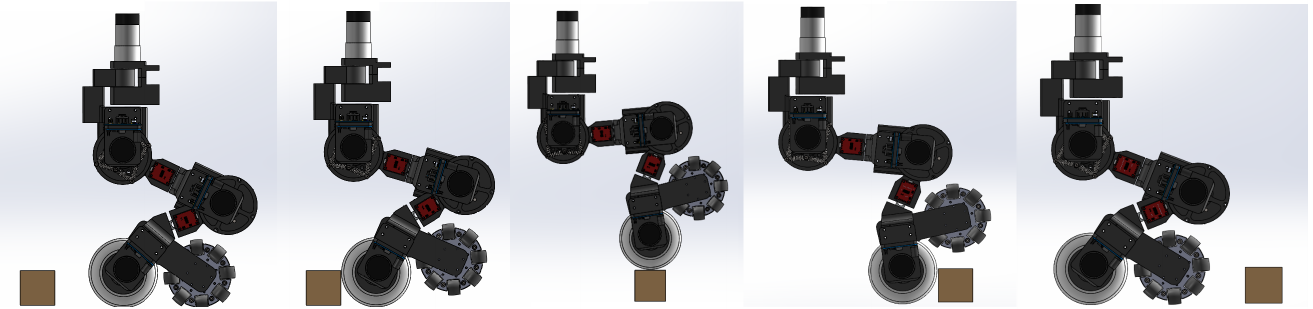
Figure 1. Obstacle surpassing